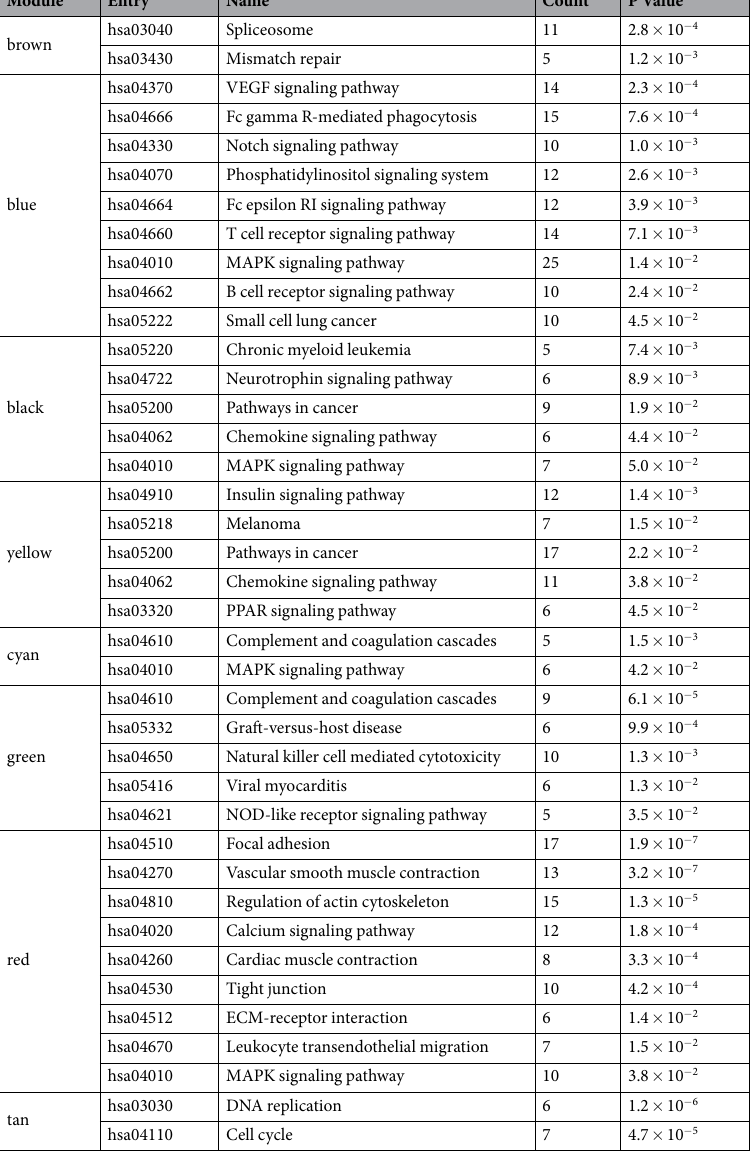
Table 2. Significant KEGG pathways (P ≤ 0.05, counts ≥ 5) associated with 12 cancer-associated